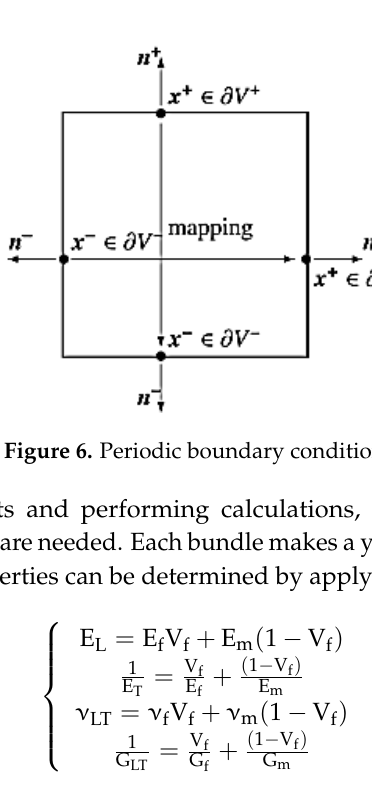
Figure 7. The real RVE ( a ), and the simulation RVE with periodic boundary conditions ( b ).